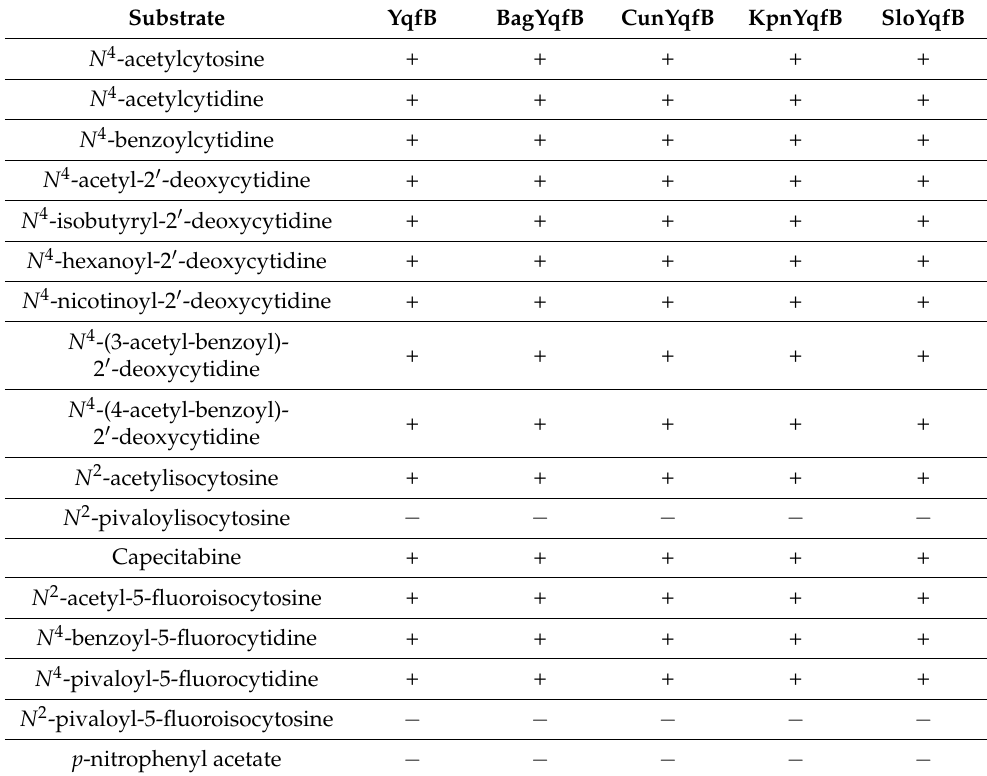
Table 1. A list of compounds used for qualitative determination of enzyme-substrate specificity. “+” indicates substrate hydrolysis within 24 h of incubation, “ − ”—hydrolysis did not occur. Substrate YqfB